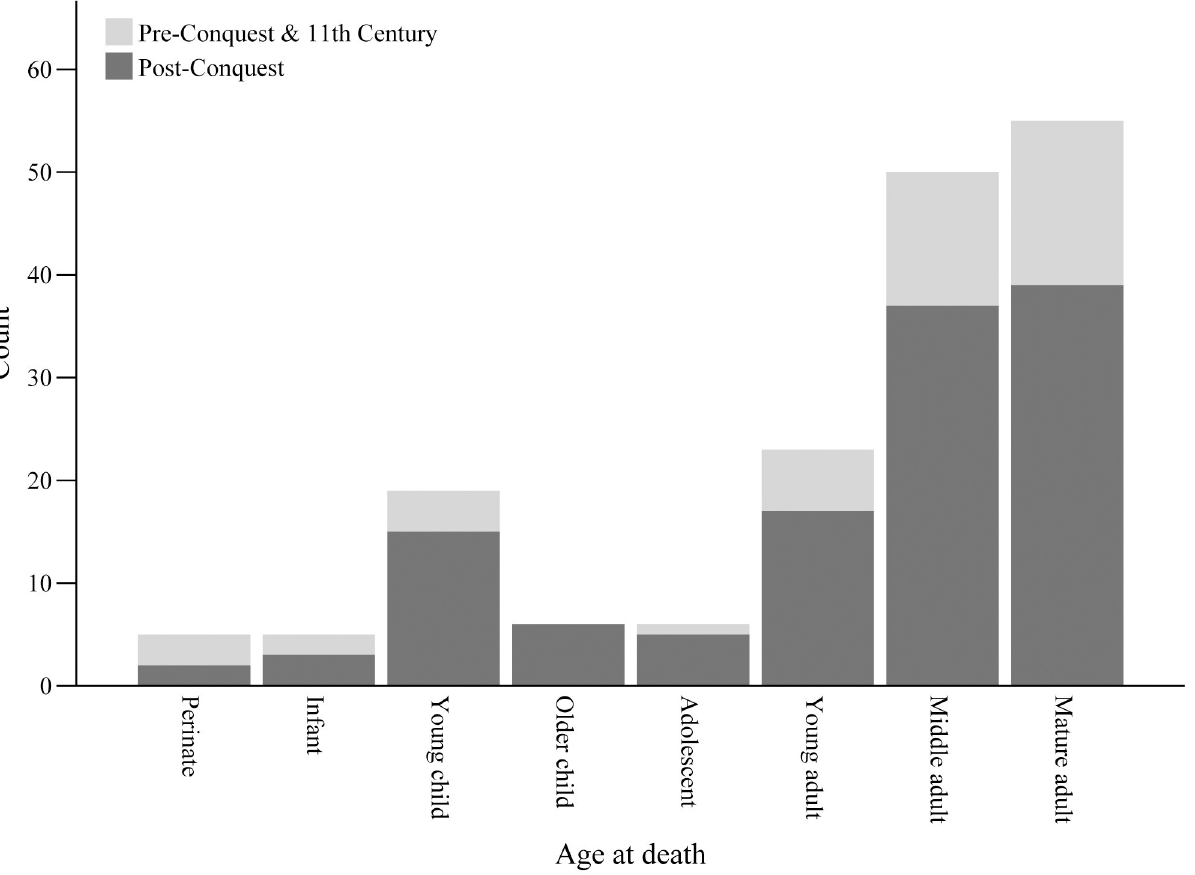
Fig 9. Age profile of human remains included in the osteological assessment. Age categories are as follows: perinate < 1 month; infant 1 month-1 year; young child 1–5 years; older child 6–11 years; adolescent 12–17 years; young adult 18–30 years; middle adult 30–45 years; mature adult > 45 years.